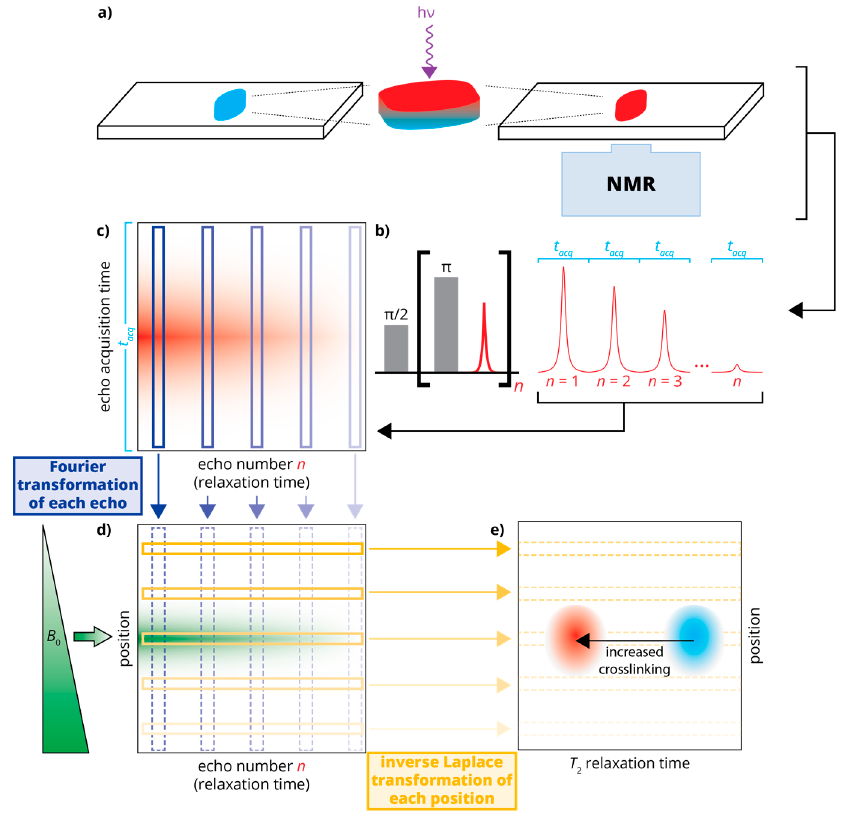
Figure 1. Schematic of the experimental setup and data processing: ( a ) An uncured sample of poly(ethylene glycol) diacrylate (PEGDA)/photoinitiator is applied to a glass slide and cured using UV irradiation. This sample is placed atop the single-sided NMR for measurements. ( b ) The NMR relaxation data is recorded using a Carr-Purcell-Meiboom-Gill (CPMG) pulse sequence [13,14] as a series of echoes, each recorded over an acquisition window of length t acq . ( c ) The echoes are arranged in a 2D data set that is subject to Fourier transformation ( d ), producing a spatially dependent signal that decays in time. ( e ) This spatially dependent signal is subject to inverse Laplace transformation, changing the time domain (signal decay) to a relaxation domain. This produces a “relaxation cross-section” or z - T 2 map, in which crosslinking can be monitored (via T 2 ) in a spatially sensitive manner.